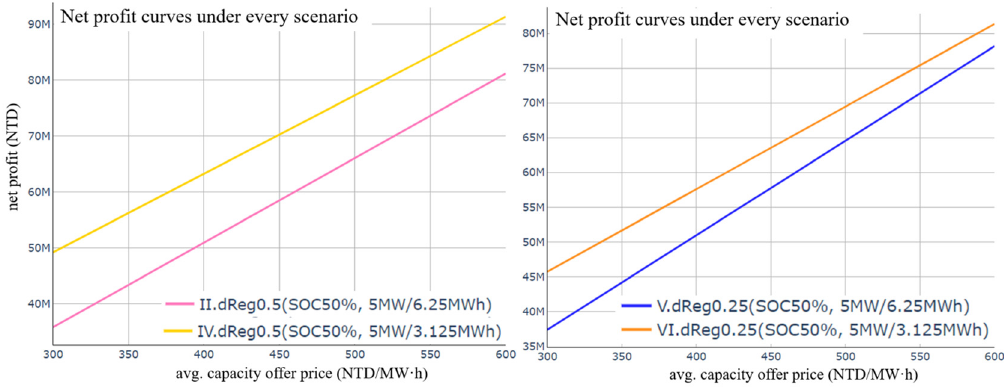
Figure 23. Net profit under different C-rates using dReg0.5 and dReg0.25.